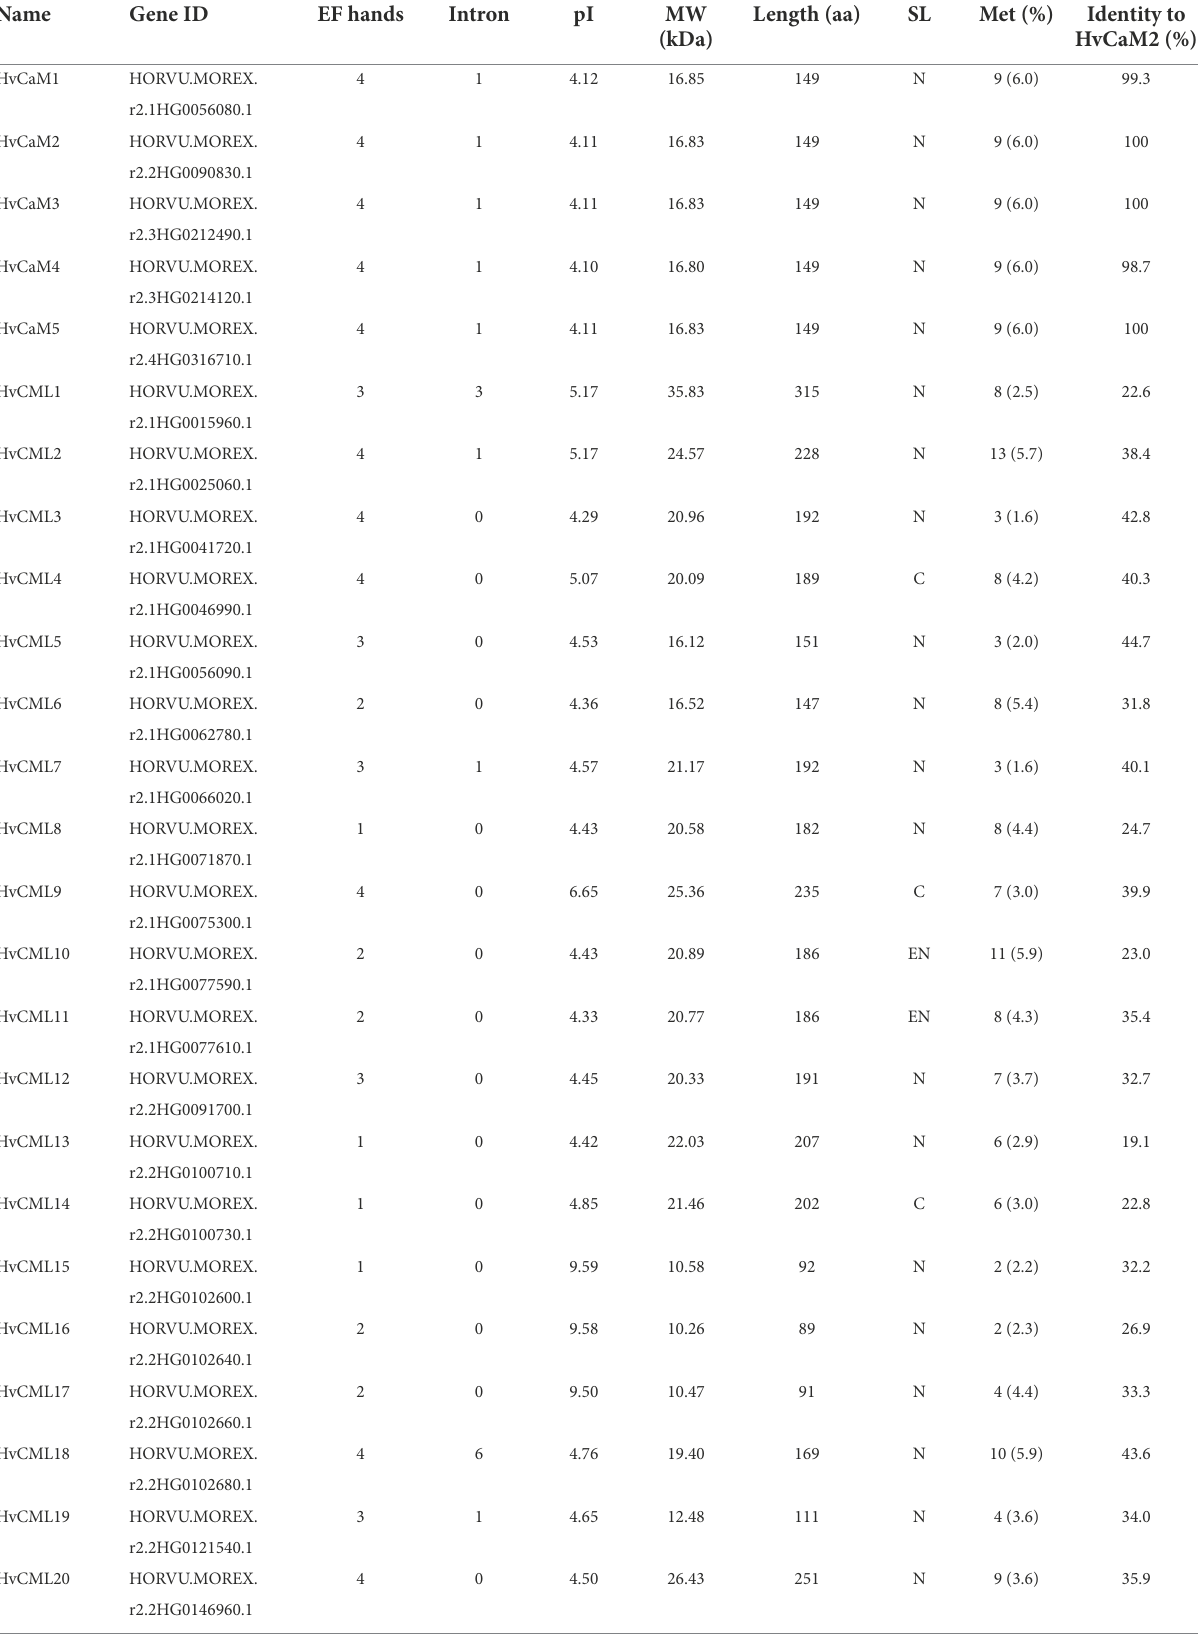
TABLE 1 Characteristics of 5 CaMs and 80 CMLs in